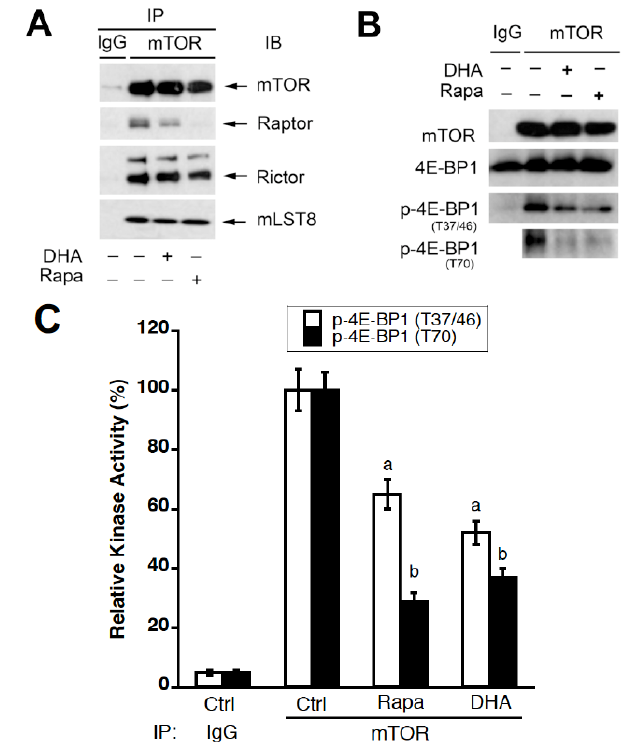
Figure 8. DHA dissociates raptor from mTOR and inhibits mTORC1 activity. ( A , B ) Rh30 cells were treated with or without DHA (3 µ M) for 24 h or with rapamycin (Rapa, 100 ng/mL, positive control) for 2 h, followed by immunoprecipitation (IP) using antibodies to mTOR or normal IgG (control). The immunoprecipitates were then subjected to immunoblotting (IB) with indicated antibodies or were used for the in vitro mTOR kinase assay by incubating with recombinant 4E-BP1 protein (as a substrate) at room temperature for 30 min, followed by Western blotting with indicated antibodies. ( C ) Semi-quantitative data (mean ± SD) of three independent experiments for ( B ). a indicates the difference with the control group of p-4E-BP1 (T37/46) ( p < 0.05); b indicates the difference with the control group of p-4E-BP1 (T70) ( p < 0.05).